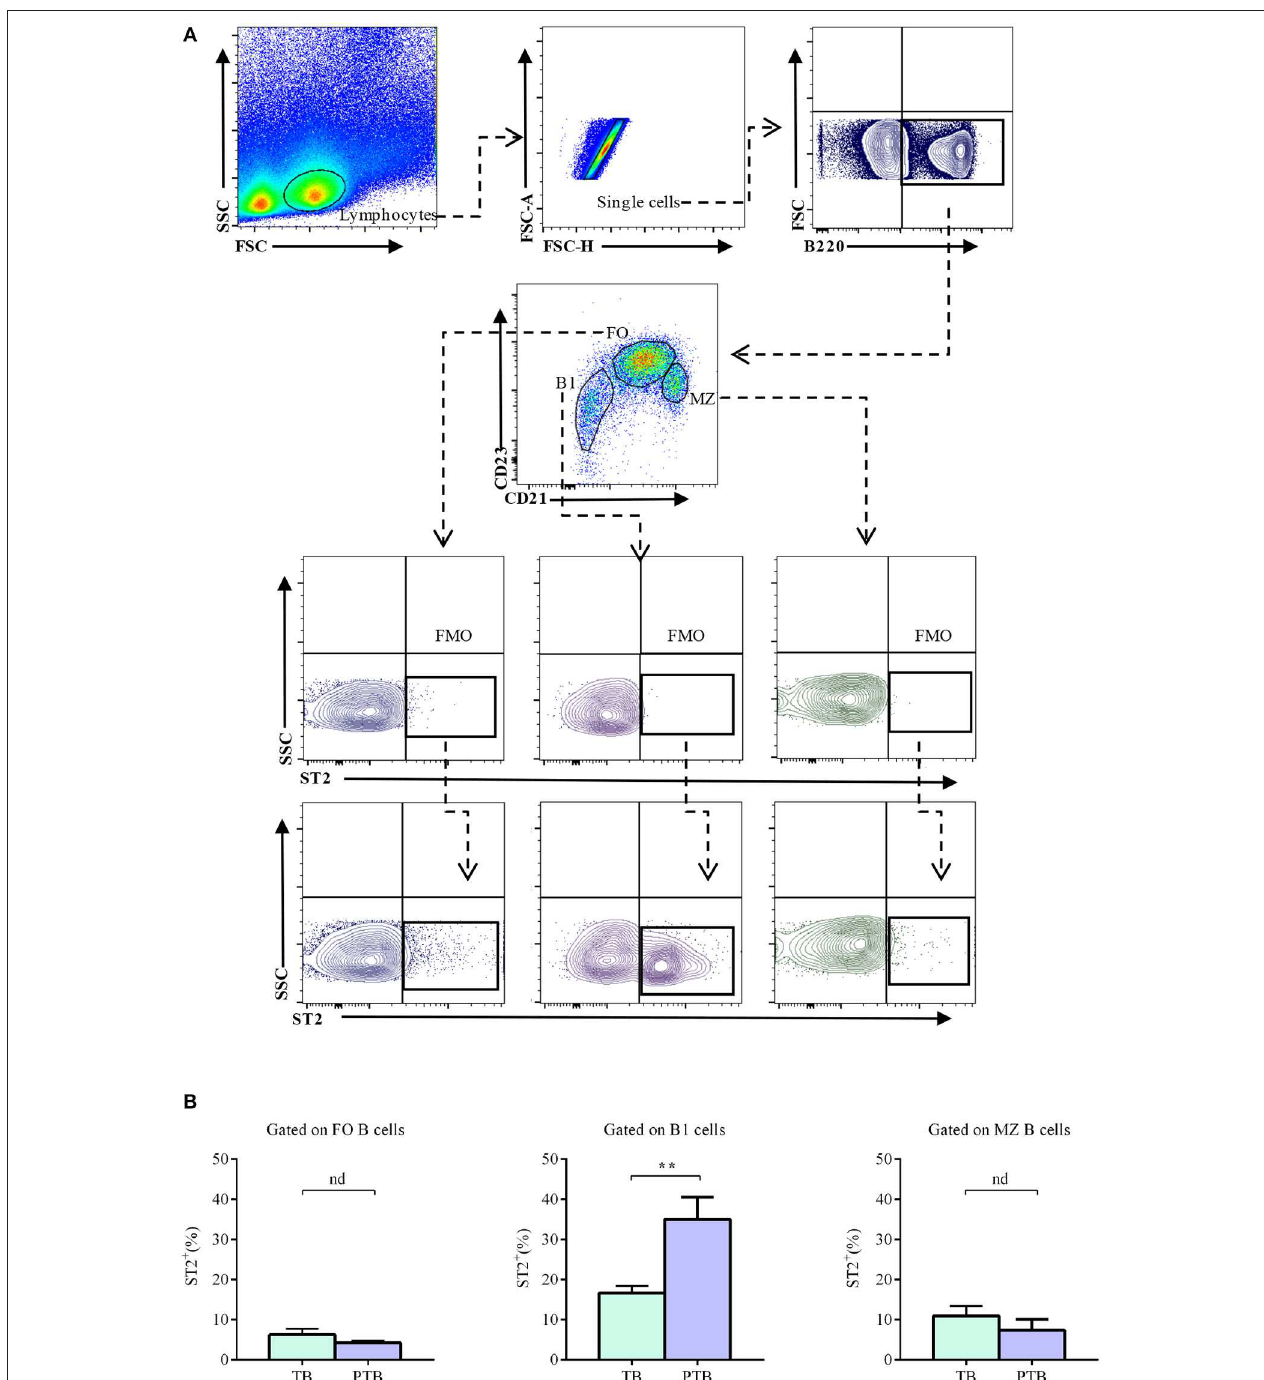
FIGURE 5 | Percentages of ST2-expressing follicular, marginal zone, and B1 B cells in the spleen of pregnant mice during the acute phase of LPS-induced preterm birth. (A) Representative pseudocolor and contour plots showing gating strategy used to quantify percentages of ST2-expressing follicular (FO), marginal zone (MZ), and B1 B cells in the acute phase of LPS-induced preterm birth and in term-pregnant control mice. Lymphocytes were gated by FSC vs. SCC, doublets were eliminated and B220 was used to define total B cells. CD23 and CD21 markers were used to identify FO (B220 + CD23 hi CD21 low ), MZ (B220 + CD23 low CD21 hi ) and B1 (B220 low CD23 − CD21 − ) B cells. Fluorescence minus one (FMO) was used as control. (B) Bar graphs showing percentages of ST2-expressing FO, MZ, and B1 B cells in preterm birth (PT; n = 6) and term birth control mice (TB; n = 6). Data are expressed as mean ± SEM. ** p < 0.01 as analyzed by two-tailed unpaired t- test.